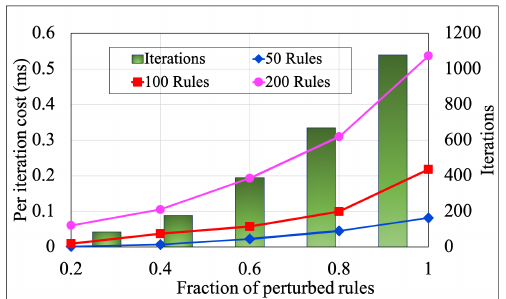
Figure 3. Number of iterations and per iteration cost vs. fraction of perturbed